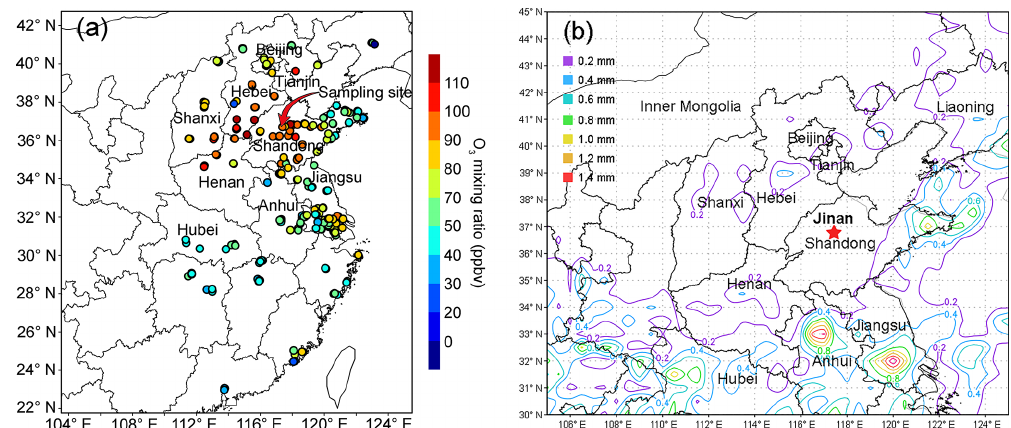
Figure 1. (a) Locations of the sampling site and the CNEMC AQMSs, and the average observed O 3 at 14:00LT on 4–11 August 2017 (colored circles). The sampling site is overlapped with the nearest AQMS in Jinan. (b) Rainfall distribution, in millimeters (mm), averaged over 4–11 August